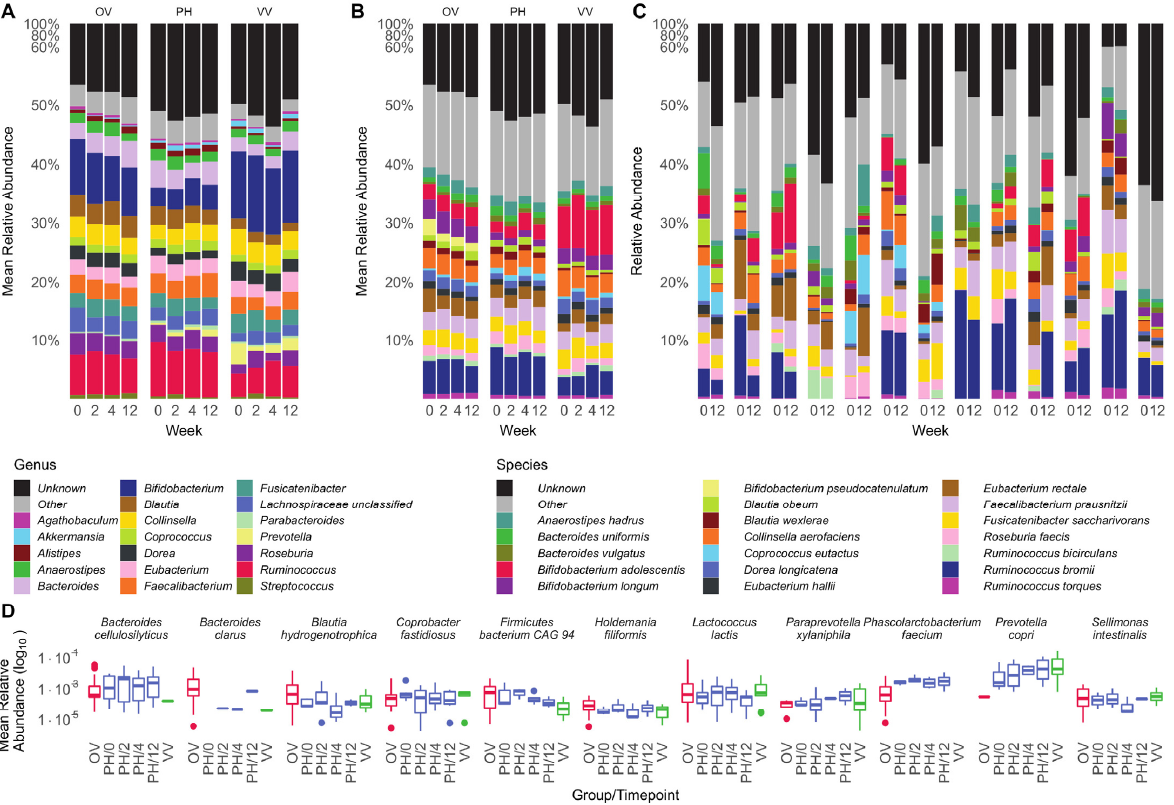
Figure 3. ( A ) Mean genus composition of the different dietary cohorts across different time points. Explicitly named genera were selected by looking at the highest mean relative abundances across all samples. ( B ) Identical information to panel Figure 3A, yet at species resolution. ( C ) Species composition of the PH cohort for the first and last measured time point. ( D ) Mean relative abundances of species with consistently largest effect sizes differentiating OV from VV. The results for the OV and VV cohorts were aggregated over all time points. OV, omnivore, VV, veg(etari)an, PH, Planetary Health group.